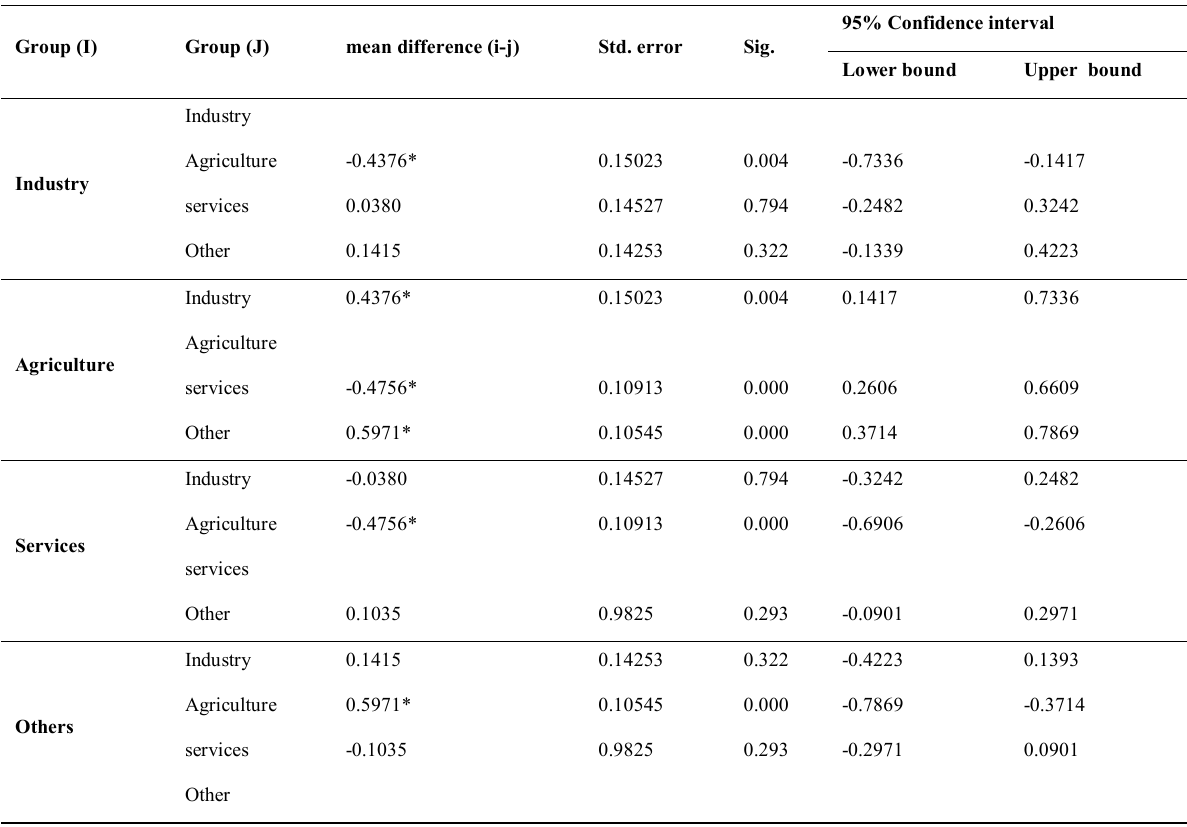
Table 14- multiple comparison of different sectors` ROA at middle investment quartiles